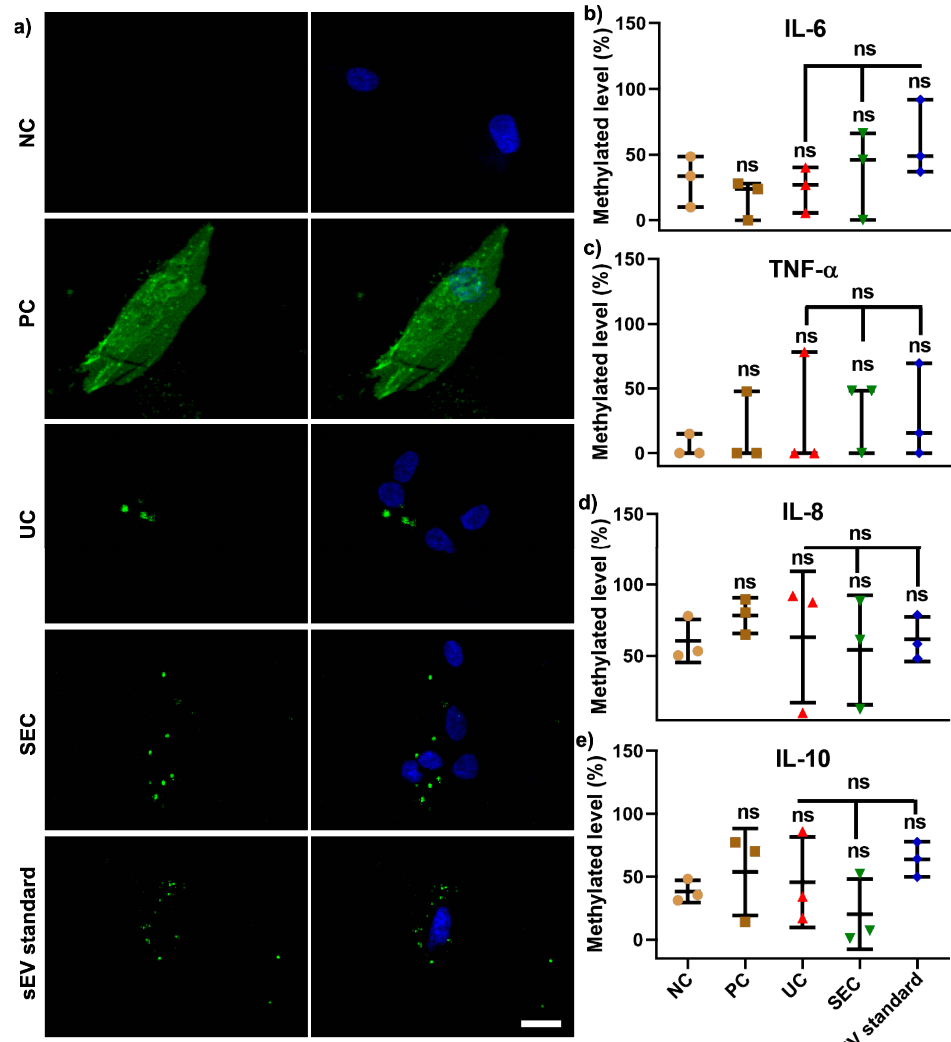
Figure 5. Pooled SEC-sEV and UC-sEV on hGFs uptake ( a ) and four inflammation cytokine gene promoters DNA methylation ( b – e ). Scale bar in ( a ): 20 µ m. NC: negative control, PC: positive control- DiO labelled cells.